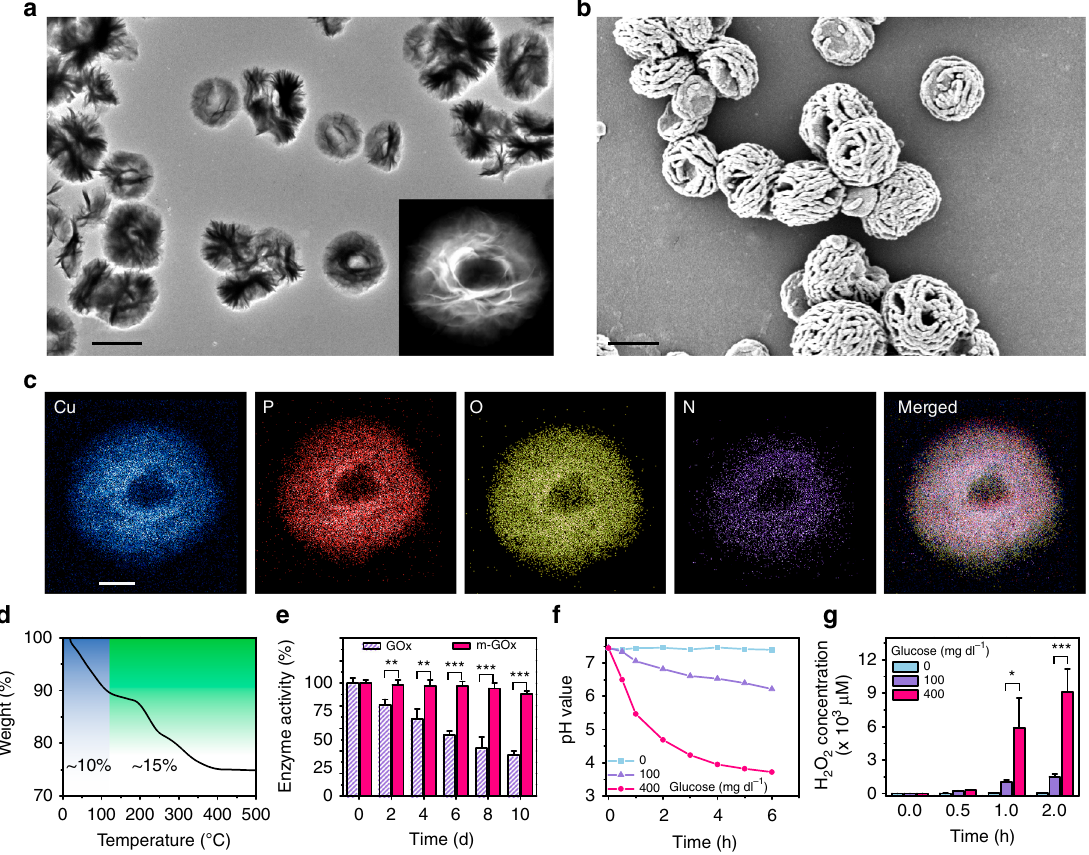
Fig. 3 Characterization of m-GOx particles and glucose responsiveness. a TEM images of m-GOx. Magni fi cation is the single m-GOx particle in dark fi eld. Scale bar, 3 µ m. b Scanning electron microscopy (SEM) image of m-GOx particles. Scale bar, 2 µ m. c Elemental mapping of m-GOx particles. Scale bar, 1 µ m. d TGA of m-GOx particles. Blue highlight indicates the water loss, and green highlighting indicates the organic component loss. e Enzyme activity decay of free GOx vs. m-GOx over time. Mean ± S.D. ( n = 3). **P < 0.01, *** P < 0.001 (two-tailed Student ’ s t -test). f Relevant pH decrease of